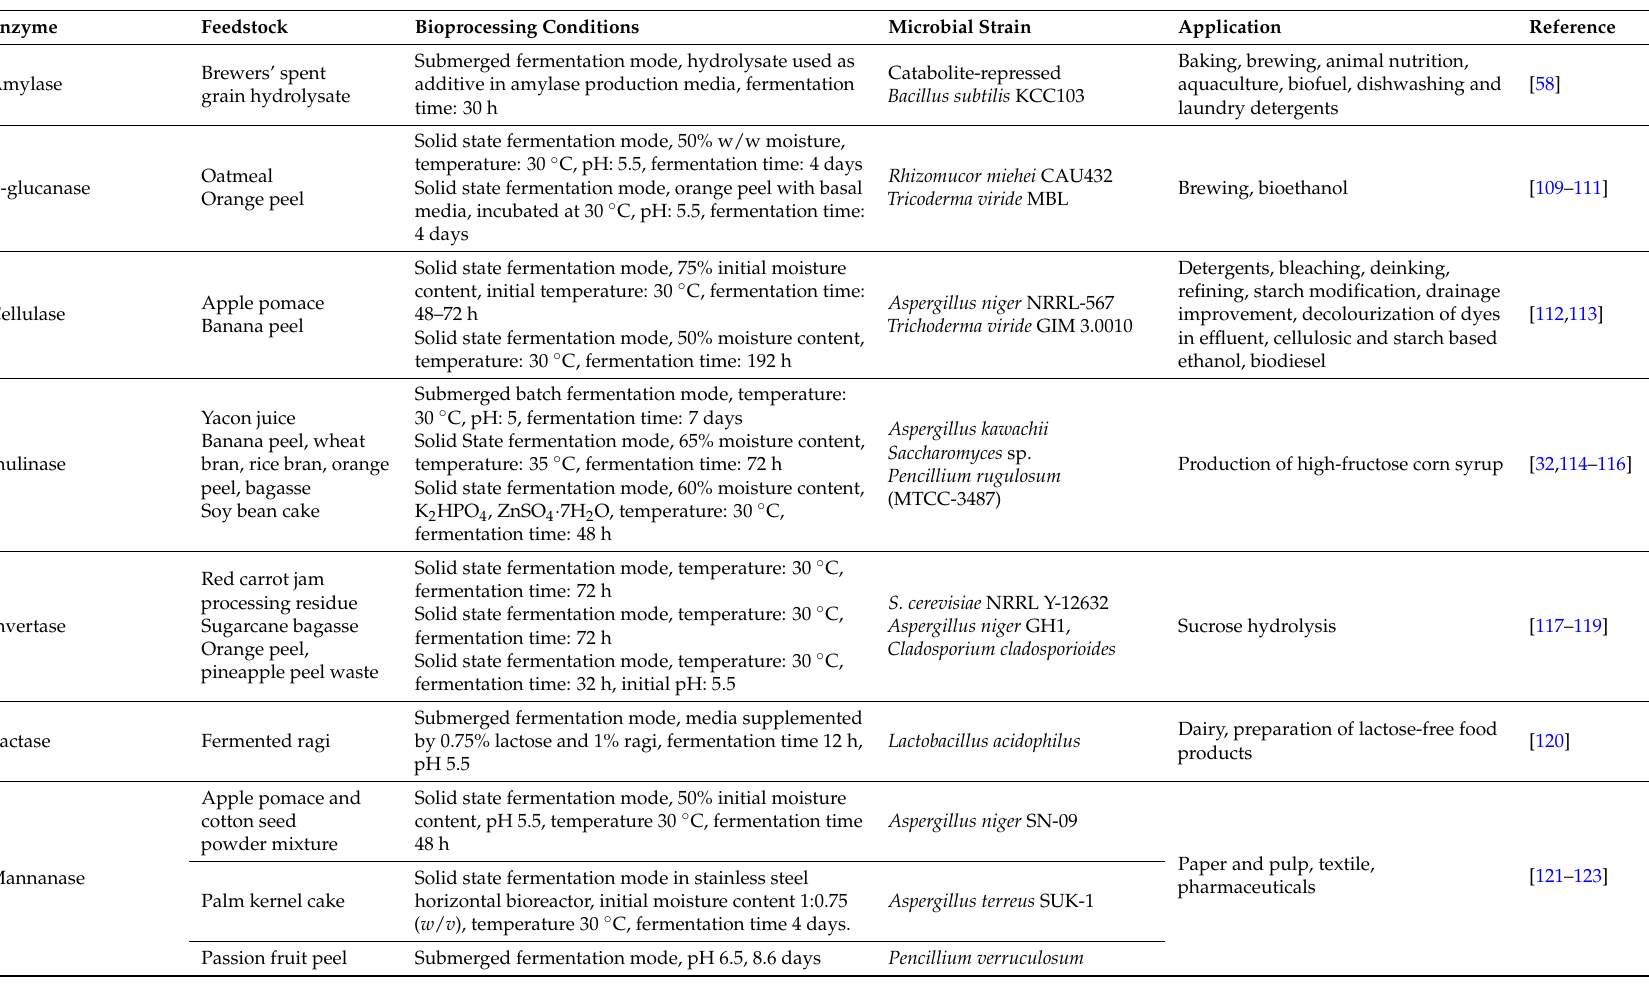
Table 1. Summary of the lignocellulosic sources that have been used as raw material for enzyme